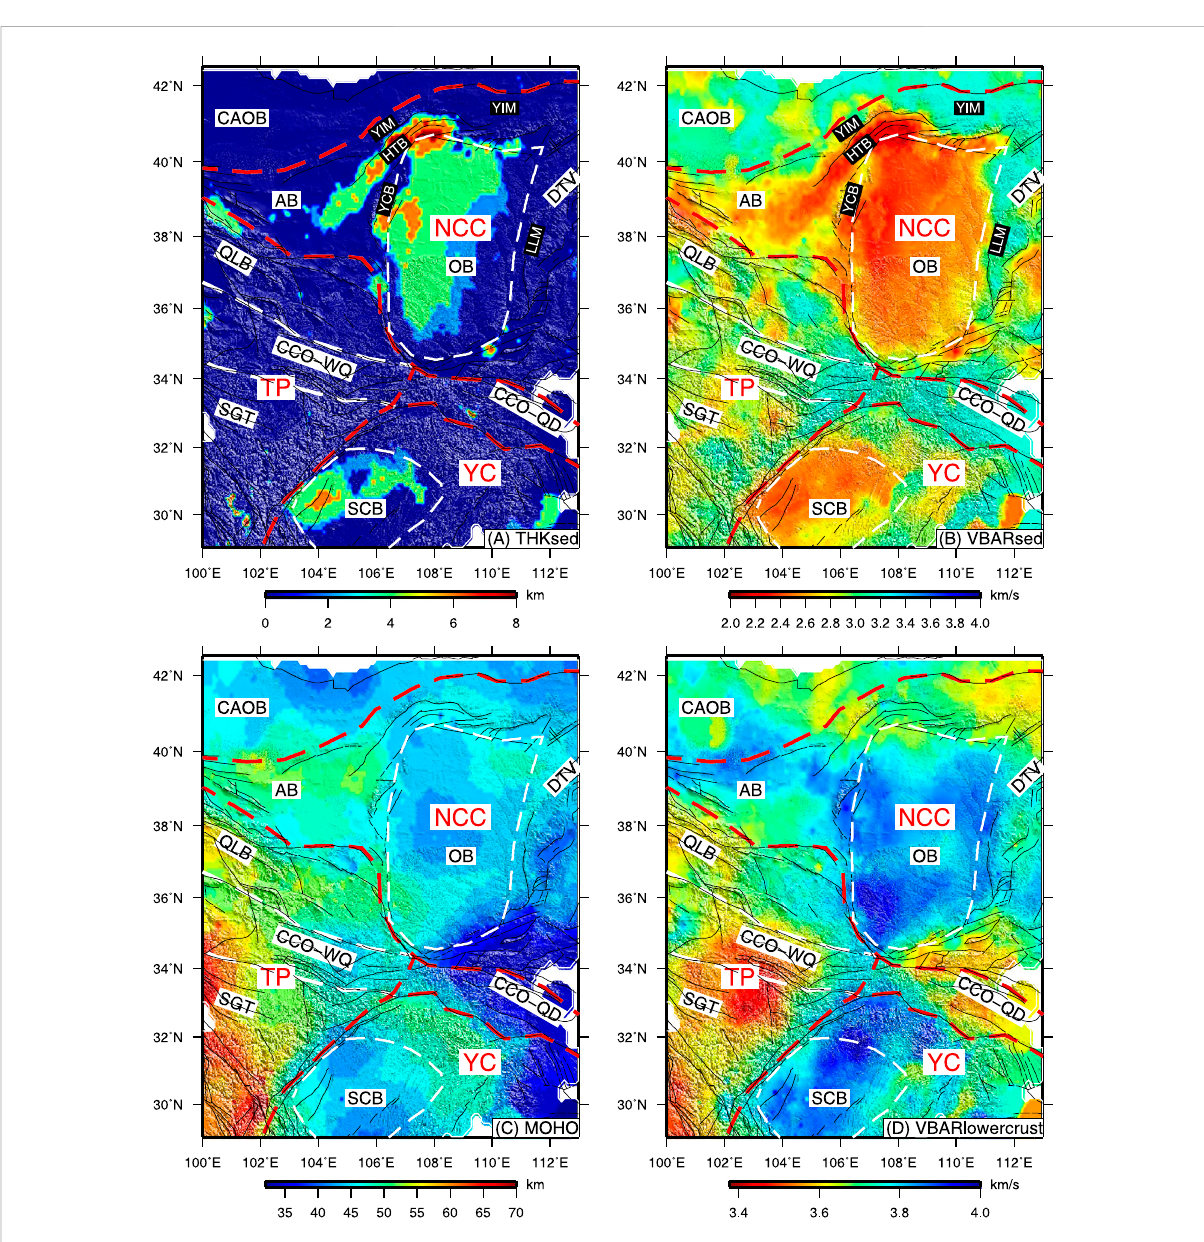
FIGURE 6 Joint inversion results of receiver functions and surface waves: (A) Sedimentary thickness; (B) Average S-wave velocity in the sediment; (C) Crustal thickness; (D) Average S-wave velocity in the lower crust. TP, Tibetan plateau; YC, Yangtze Craton; CAOB, Central Asia Orogenic Belt; NCC, North China Craton; SGT, Songpan-Garze Terrane; QLB, Qilian tectonic belt; OB, Ordos Block; AB, Alxa Block; CCO, Central China Orogen (or Qinlingtectonicbelt);WQ,WesternQinling;QD,QinlingDabie;DTV,DatongVolcano;YIM,Yinmountain;LLM,Lvliangmountain;SCB,Sichuan basin; YCB, Yinchuan basin; HTB, Hetao